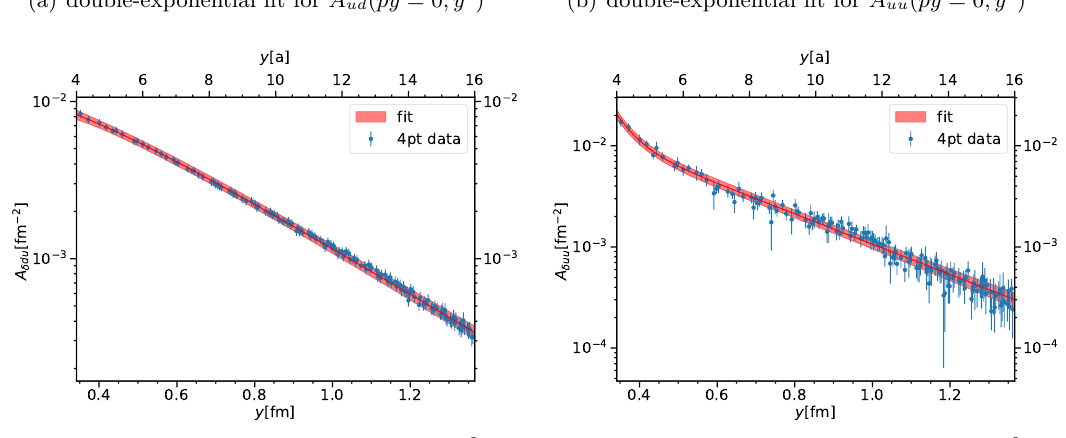
(b) double-exponential fit for A uu ( py = 0 , y 2 )